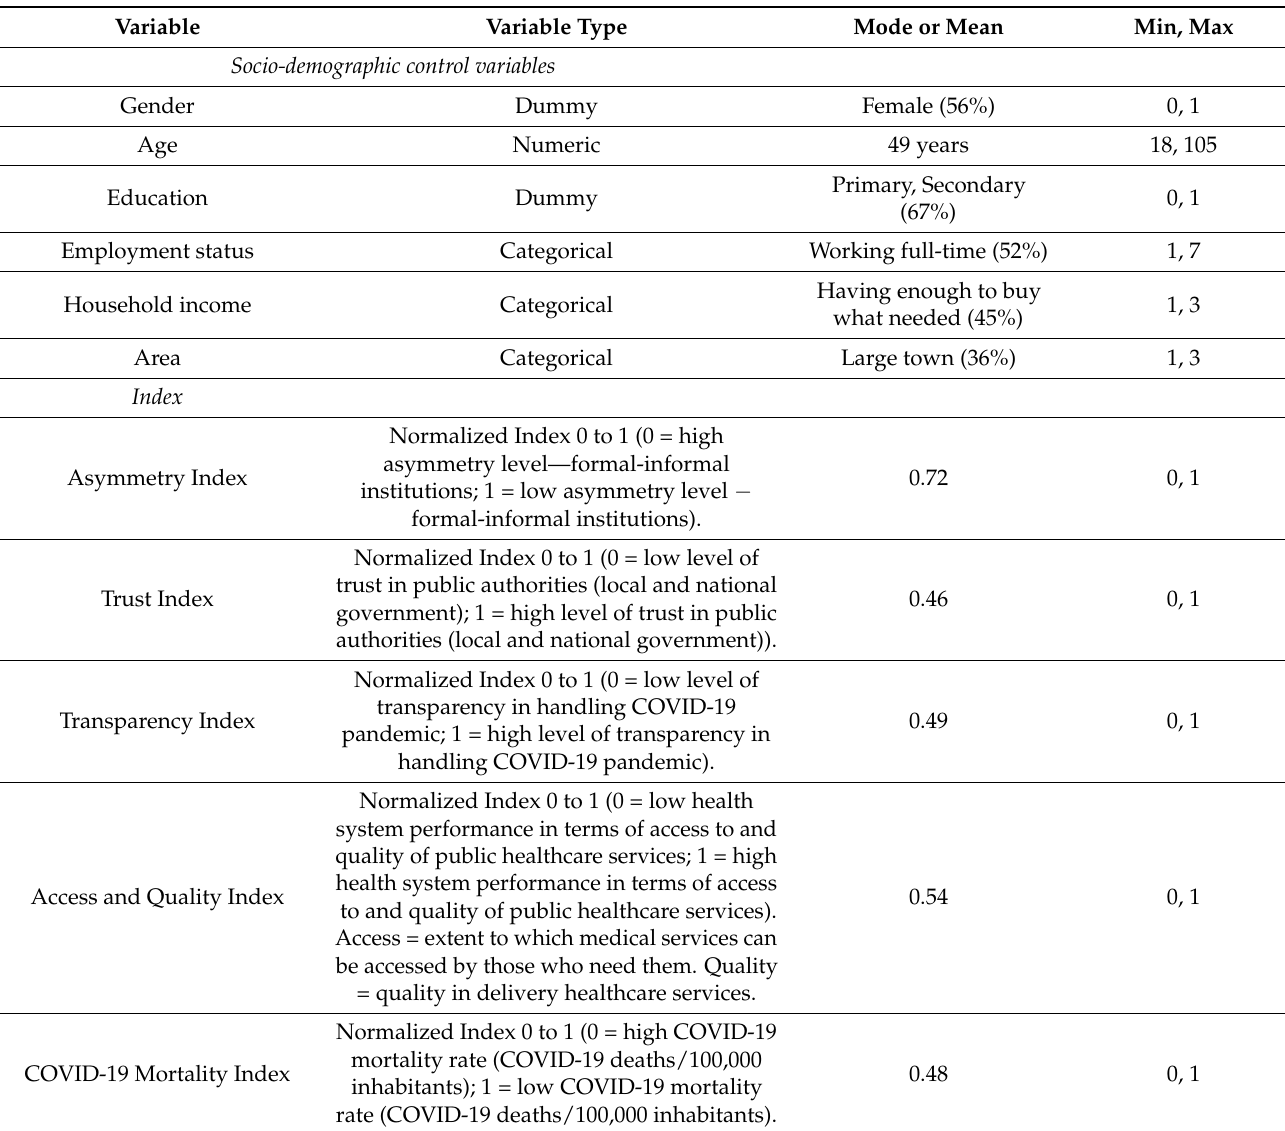
Table A1. Analysed variables ( n =